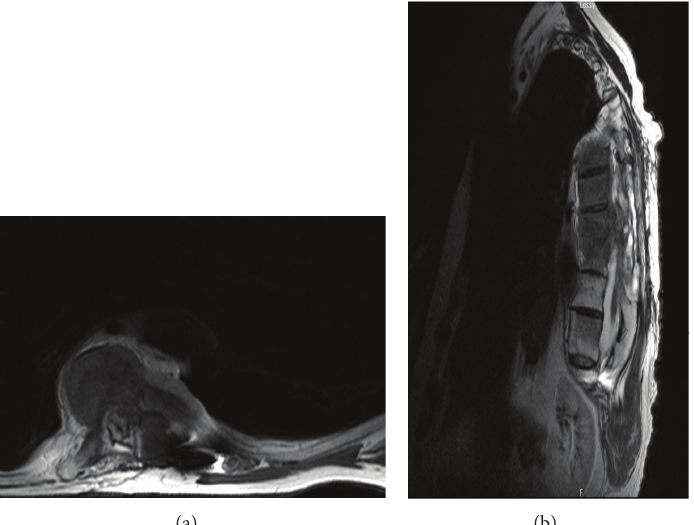
Figure 5: His last axial and sagittal MRI images eight months after his last surgery illustrate aggressive tumor involvement of the thoracic spine with significant cord compression.